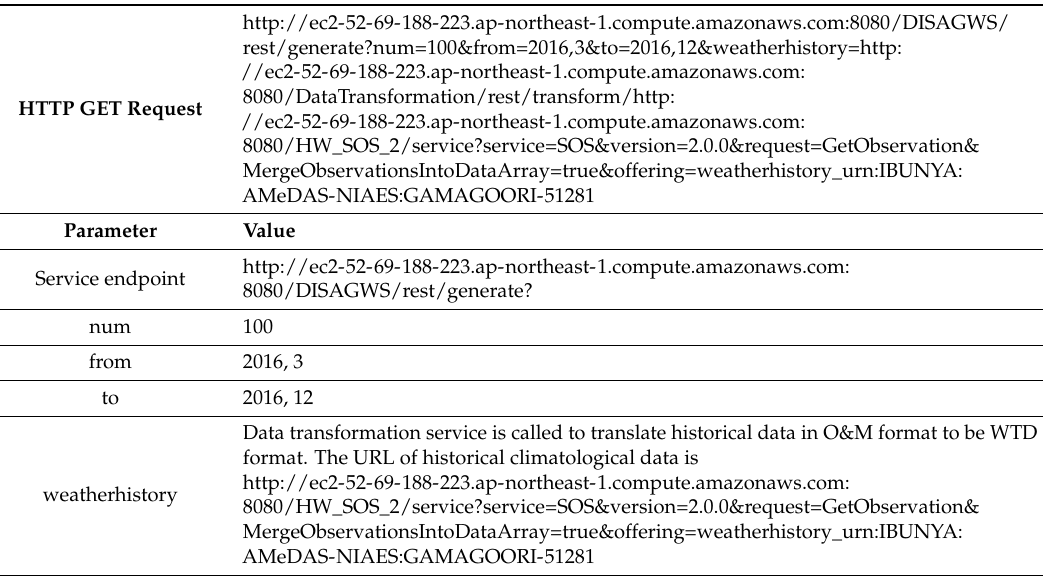
Table 9. DISAG Web Service